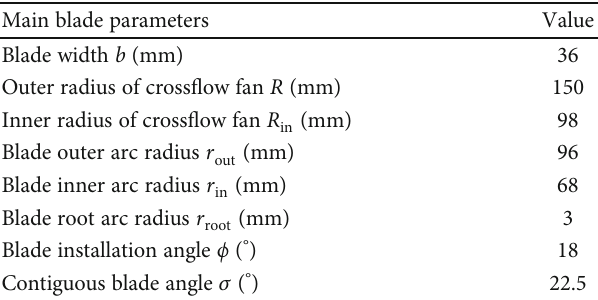
Table 2: Main parameters of cross- fl ow fan